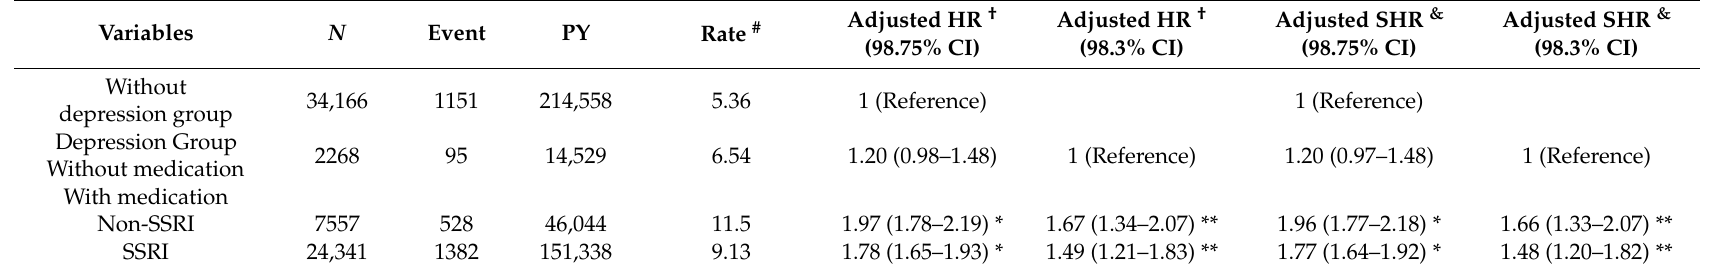
Table 4. Incidence and hazard ratio of cervical spondylosis associated with medication of serotonin-specific reuptake